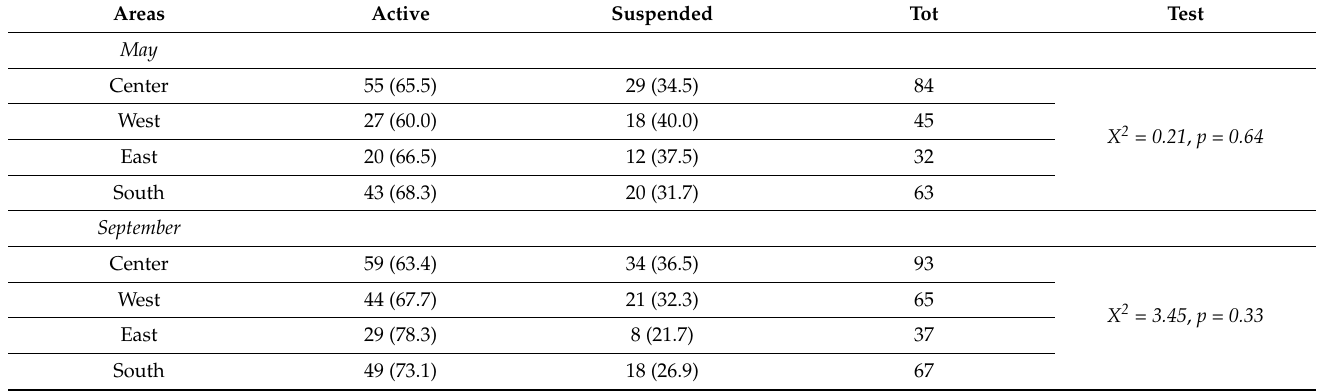
Table 3. Numbers of registered trials in 2021 according to different geographical areas (center, east, west, south) and status (active/suspended) as of May and September